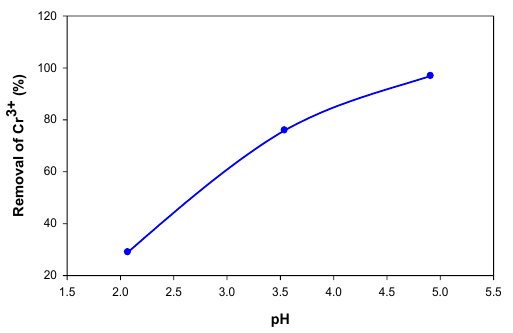
Fig. 5. Effect of inter pH on the Cr 3+ removal. Current density 9.34 mA/cm 2 , initial Cr 3+ concentration 1000mg/L, time 30 minute.